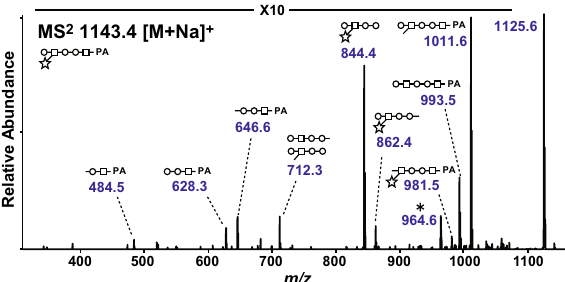
Figure 2. LC–MS/MS of the pentose-containing glycan. MS 2 spectrum of the pentose-containing PA-glycan at m/z 1143 [M + Na] + is shown. Symbol representations of glycans are as follows: circle, hexose; square, HexNAc; star, pentose. The asterisk indicates an unassigned fragment mass.